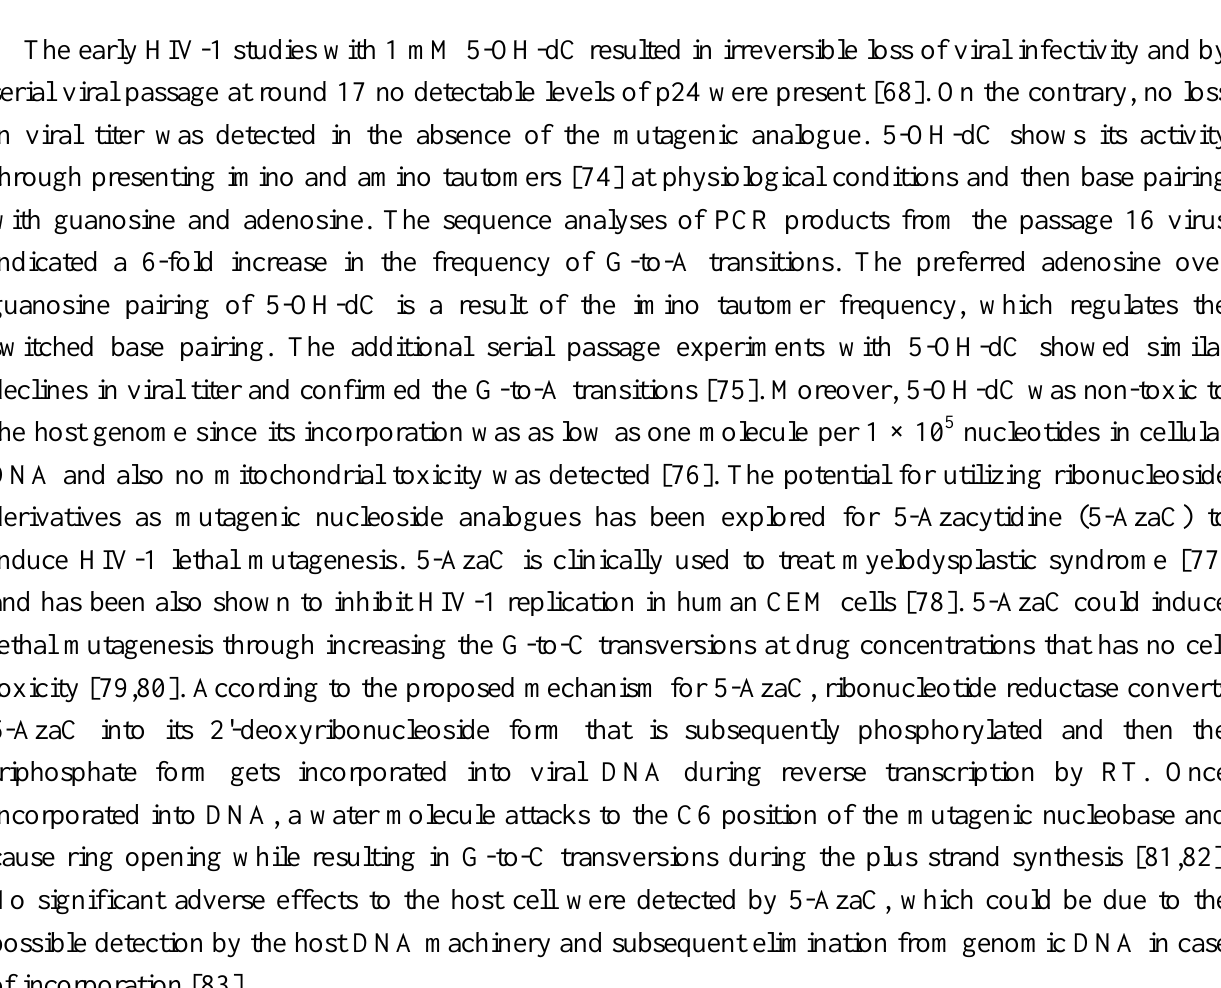
Figure 1. Schematic representation of HIV-1 lethal